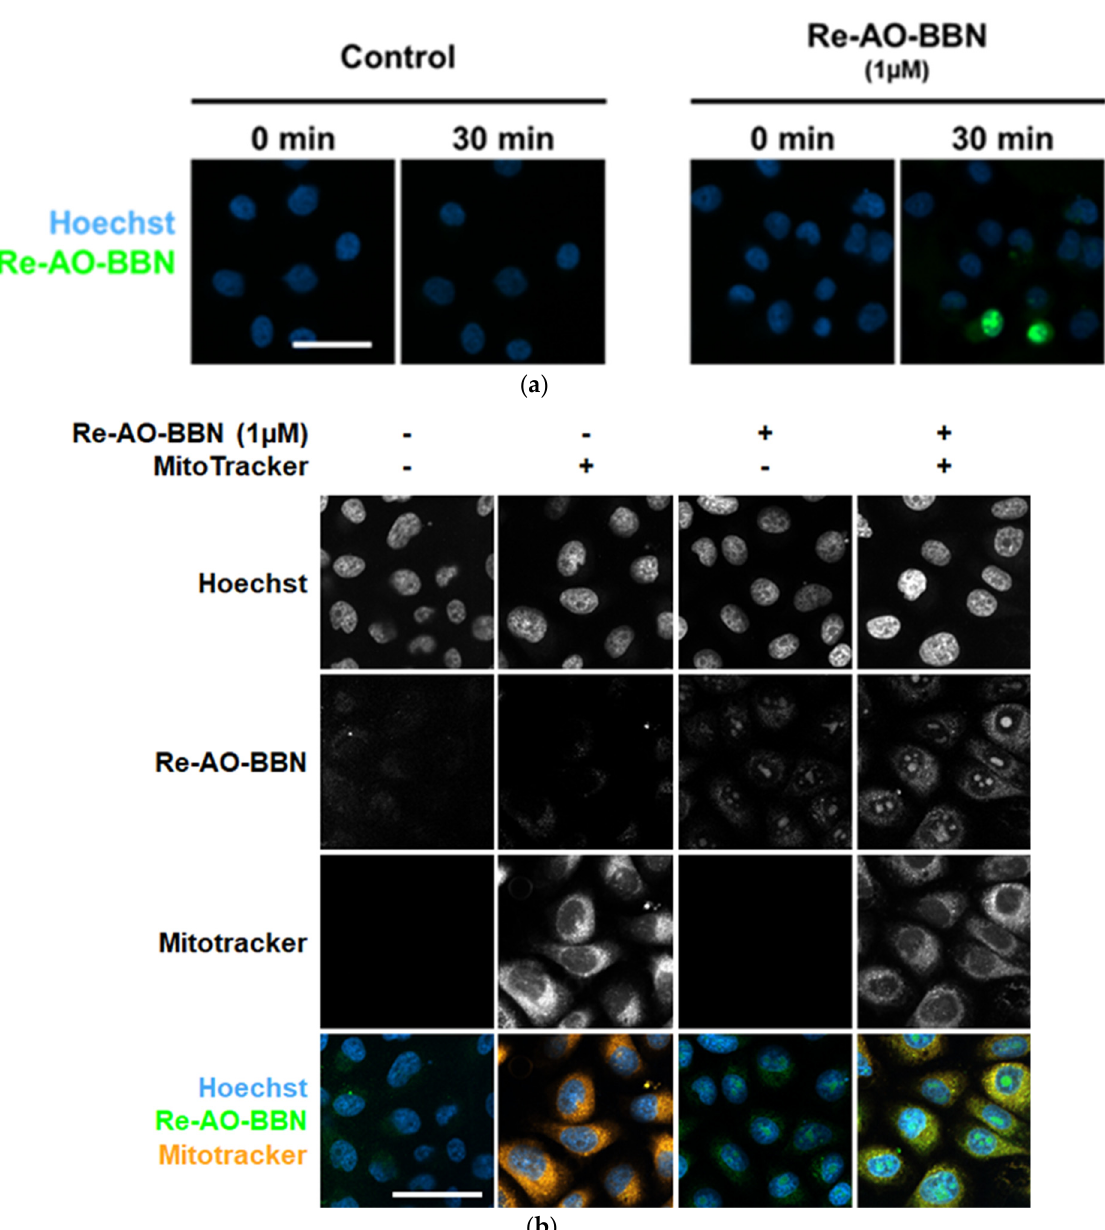
Figure 5. The cellular uptake and localization of Re-AO-BBN in PC3 evaluated by fluorescence microscopy. ( a ) Live cell uptake of Re-AO-BBN (1 µM). ( b ) Intracellular localization of Re-AO-BBN and MitoTracker. Confocal slices show nucleolar and cytoplasmic accumulation of Re-AO-BBN . Colocalization of Re-AO-BBN and MitoTracker fluorescence is quantified at Pearson’s r = 0.31. Mitochondrial morphology is not changed by the presence of Re-AO-BBN . Scale bar = 50 µm.